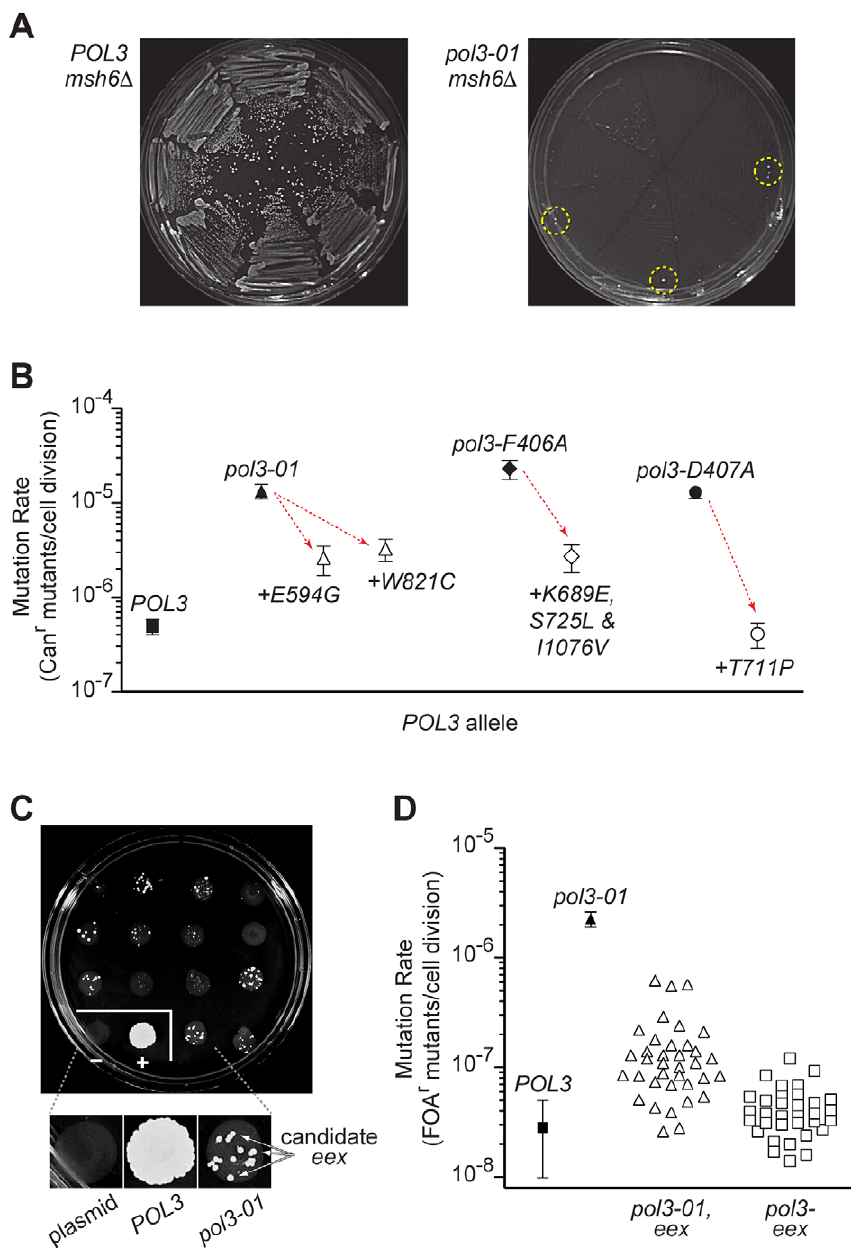
Figure 2. Escape from error-induced extinction. A) Emergence of colonies that escape pol3- 01 msh6 D synthetic lethality. Each segment of an FOA-containing SC plate (eight segments per plate) was streaked with an individual colony of POL3–LEU2 POL3–URA3 msh6 D (left) or pol3- 01 –LEU2 POL3–URA3 msh6 D (right) cells to select for loss of the POL3–URA3 plasmid (see Figure S1). Resultant POL3 msh6 D cells formed abundant visible colonies (left), whereas pol3-01 msh6 D cells did not (right). Colonies that escape pol3-01 msh6 D synthetic lethality ( eex mutants) arose at low frequency near the outer margins of the plate (circled) where cell densities were highest. Similar results were seen when pol3-F406A or pol3-D407A were shuffled into msh6 D cells (not shown). B) Antimutator effects of eex alleles encoding second-site changes in Pol d . Rates of spontaneous mutation to canavanine-resistance (Can r ) conferred by pol3-01 , pol3-F406A or pol-D407A alone (filled symbols) and combined with intragenic eex alleles (open symbols) were determined in MSH6 cells. Downward arrows illustrate the reduction in mutation rates ( i.e. , the antimutator effect) caused by the second-site, amino-acid substitutions indicated beneath each datum point. Error bars show 95% confidence intervals. C) Representative plate from large-scale screen for eex mutants. Approximately 10 6 cells from multiple independent pol3-01–LEU POL3–URA msh6 D parent colonies were plated separately in , 1-cm spots on FOA-containing SC medium. LEU -only and POL3–LEU plasmids were also shuffled into msh6 D cells as controls. FOA-resistant colonies arose at varied frequencies from each parent clone. Insert, magnified view showing colonies that are candidate eex mutants. plasmid, LEU-only plasmid with no POL3 gene. D) Mutation rates of eex mutants. Rates of spontaneous mutation to FOA-resistance (FOA r ) were measured in a MMR-proficient strain with a chromosomal URA3 reporter gene. Each datum point represents a different POL3 allele. Mutation rates were determined from multiple independent fluctuation analyses of each allele. Confidence intervals (95%) are shown for POL3 and pol3-01 . Mutation rates and confidence intervals of individual eex alleles are in Table 1 and Table